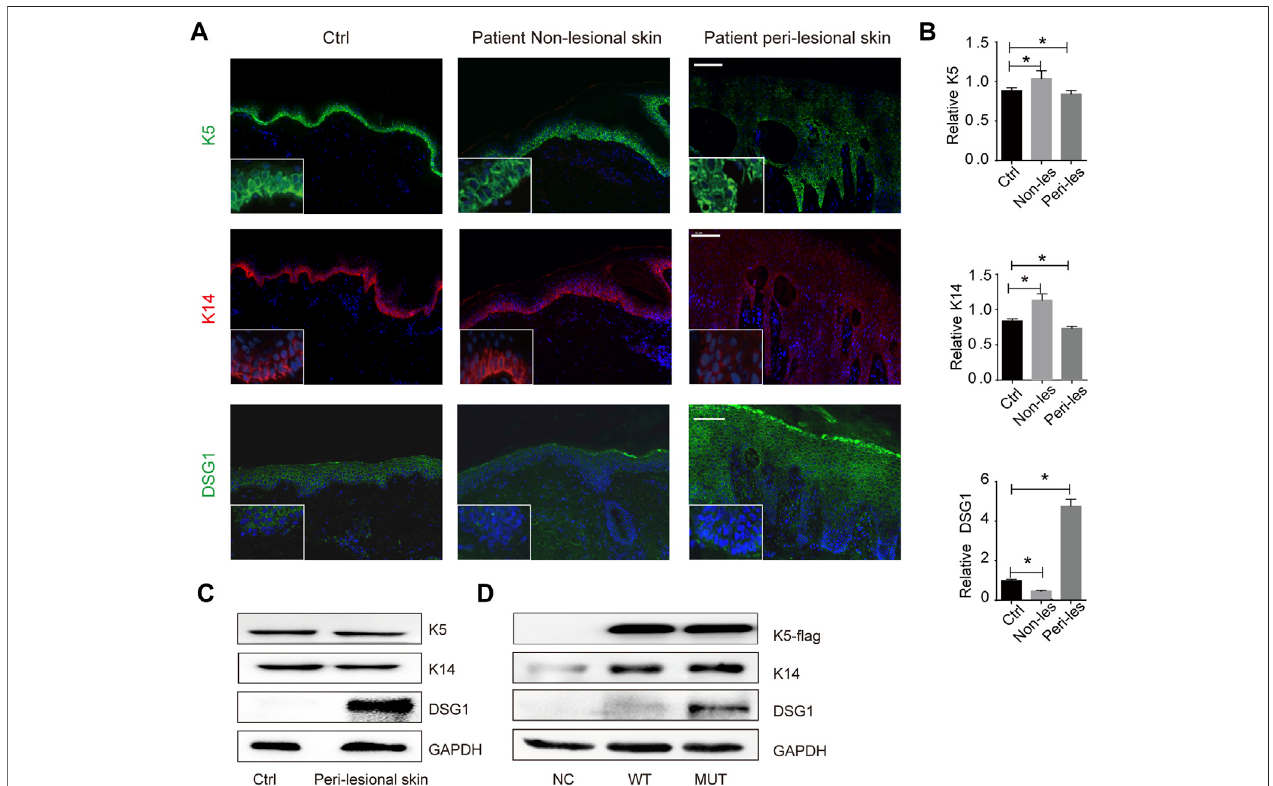
FIGURE2| KRT5 mutationmaintainsK5/K14steadyproteinlevelsbutsigni fi cantlyincreasedDSG1level. (A) Immuno fl uorescencestainingforK5,K14,andDSG1 revealed slightly decreased expression of K5 and K14 and signi fi cantly increased DSG1 in patient peri-lesional skin biopsy. DAPI, 4 ′ ,6-diamidino-2-phenylindole. Bars, 100 µm. (B) Quanti fi cation of the signal in (A) . Statistical signi fi cance was assessed by ordinary one-way ANOVA, followed by Bonferroni ’ s multiple comparison. * p < 0.05, Ctrl, n (cid:1) 3. (C) Immunoblotting for K5, K14, and DSG1 in vivo . (D) Immunoblotting for K5- fl ag, K14, and DSG1 in vitro . GAPDH used as a loading control. Three biological replicates were conducted (C,D)